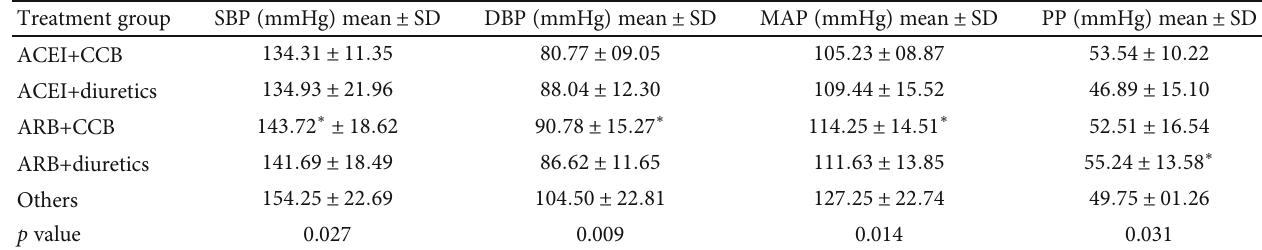
Table 3: Peripheral blood pressure measurements among various drug combinations. Treatment